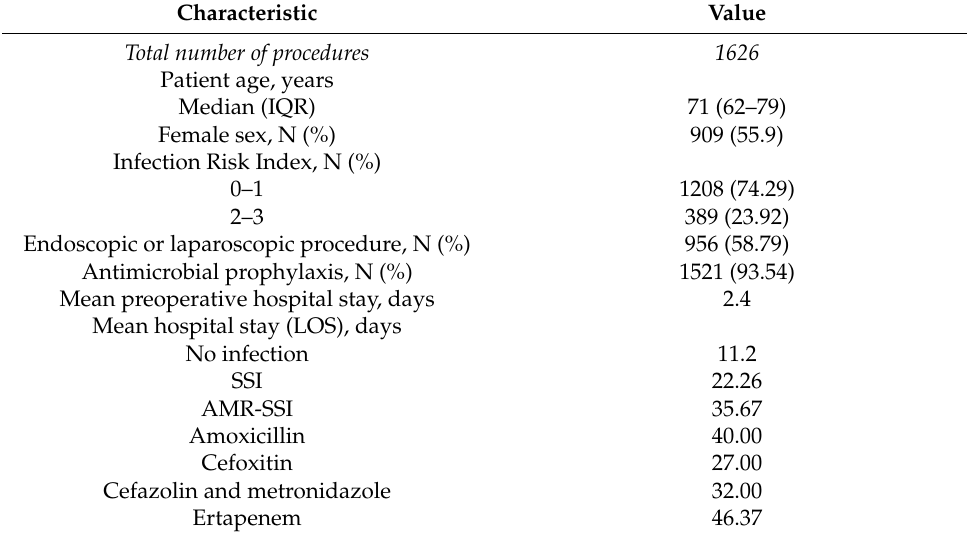
Table 2. Demographic and clinical characteristics of patients undergoing elective colorectal surgery in Piedmont,